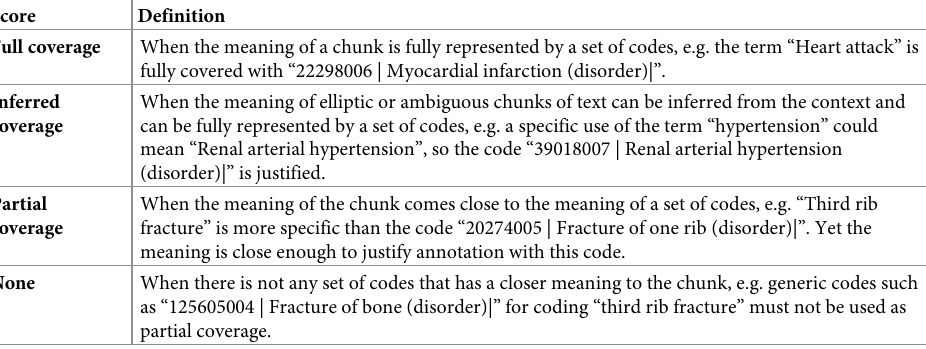
Table 2. Definition of concept coverage scores for ASSESS CT manual